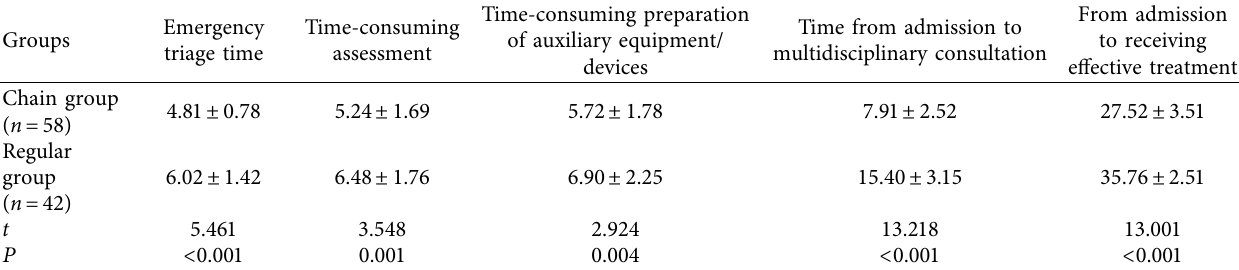
Table 1: Comparison of first aid efficiency between two groups ( x ± s ,